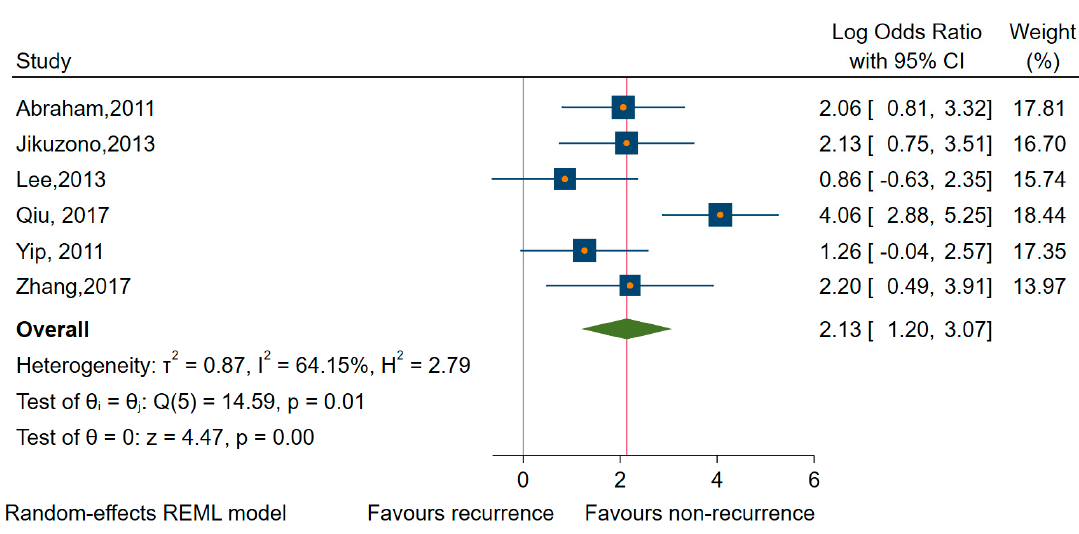
Figure 5. Forest plot of the association between the upregulated miRNAs and DFS/RFS.